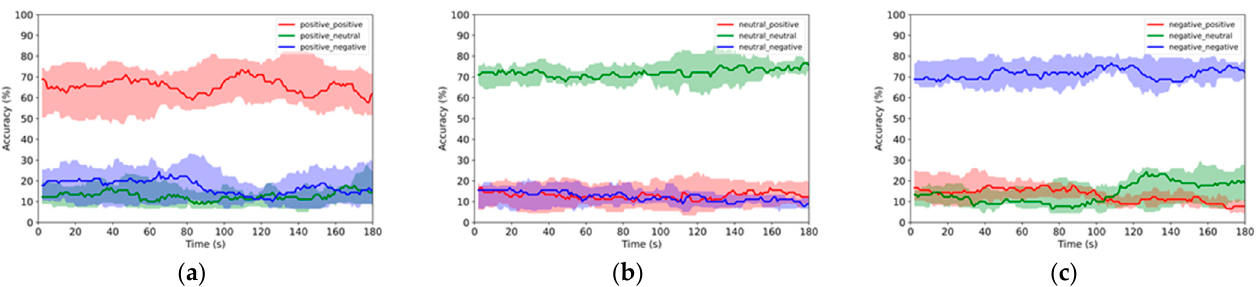
Figure 4. Online emotion recognition results when using PSD features. The legends are described as “ground truth emotion _ online predicted emotion” (e.g., positive _ positive means that the ground truth emotion and online predicted emotion are both positive, while positive _ negative means that the ground truth emotion is positive, but the online predicted emotion is negative.). The solid lines represent the median values of probabilities for online predicted results and the boundaries of the shadow areas illustrate the 25th percentile and 75th percentile values: ( a ) online recognition of positive emotion samples; ( b ) online recognition of neutral emotion samples; ( c ) online recognition of negative emotion samples.